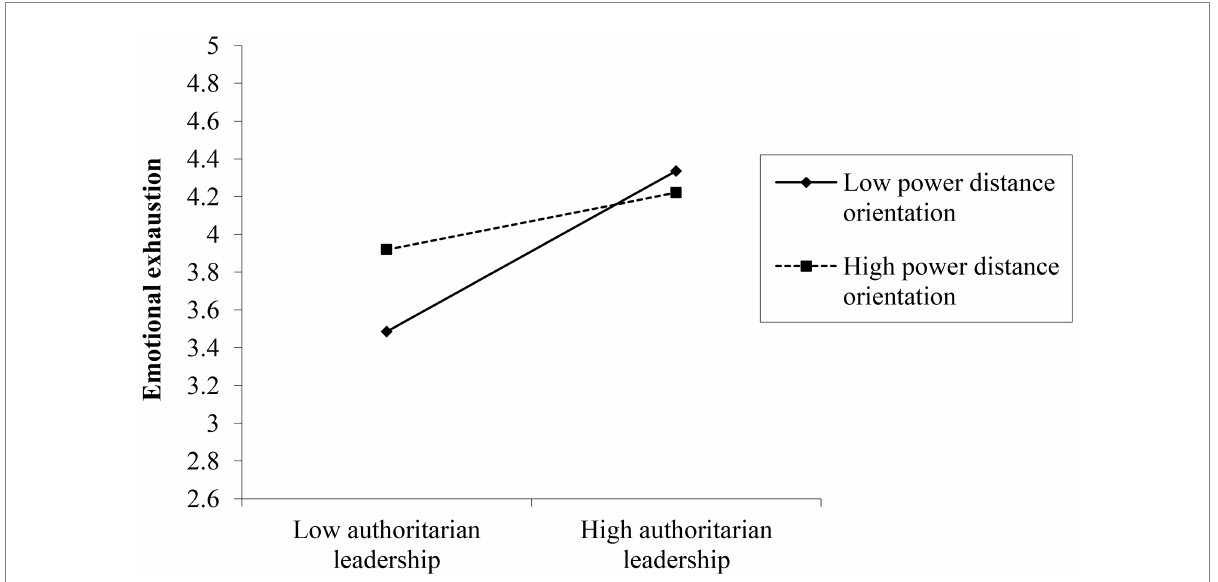
FIGURE 2 The moderating effect of power distance orientation on the relationship between authoritarian leadership and emotional exhaustion.